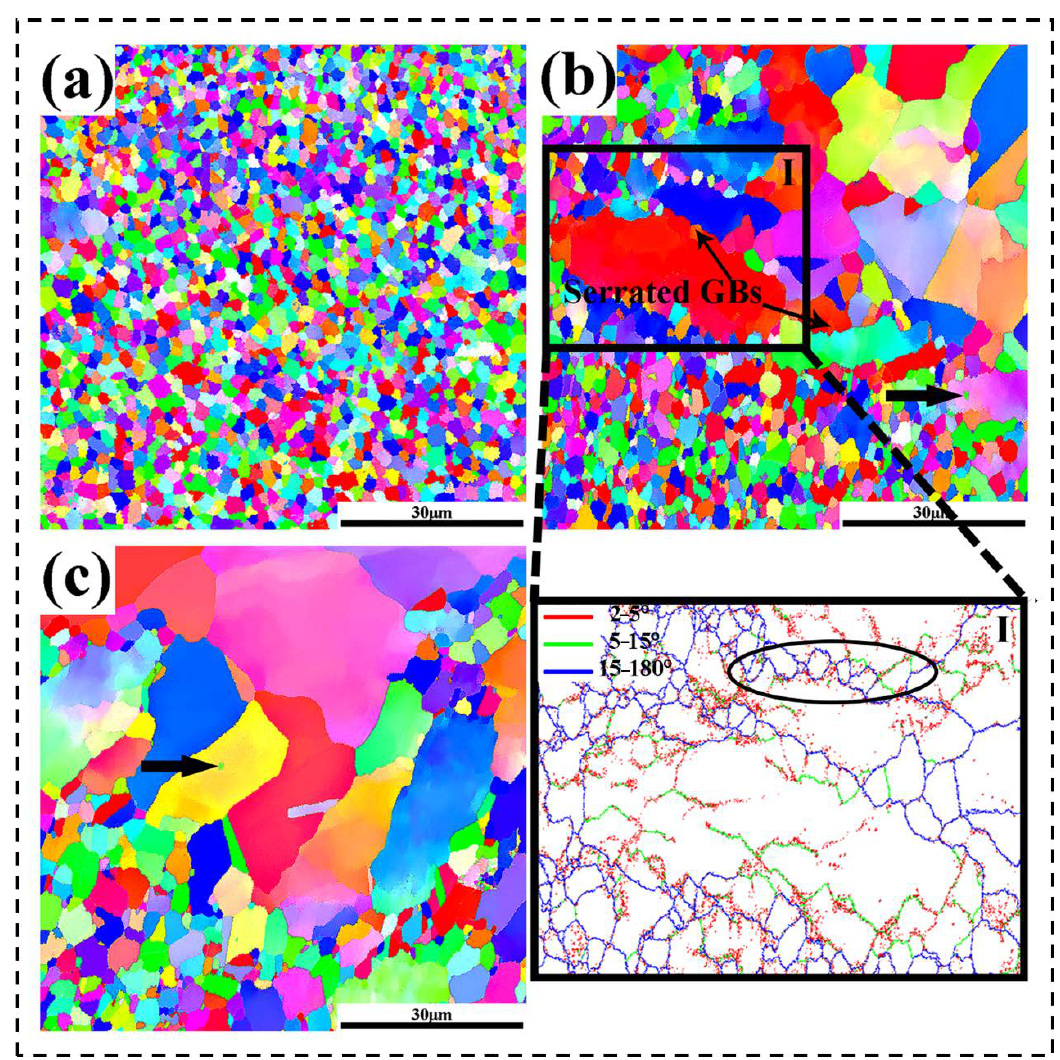
Figure 5. The microstructure obtained for the studied superalloy at the true strain of 0.916 and 1393 K with a strain rate of ( a ) 0.01 s −1 , ( b ) 0.1 s −1 , and ( c ) 1.0 s −1 .